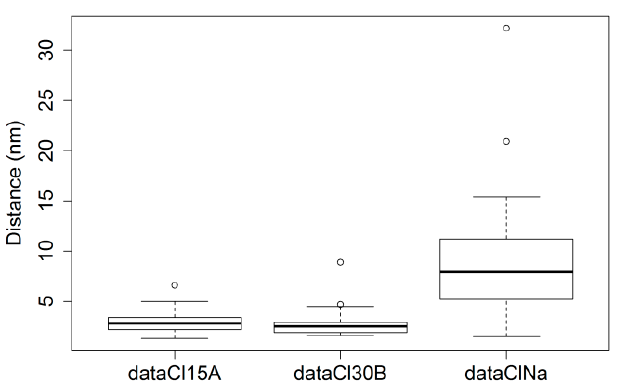
Figure 5. Boxplot representation for the measured distances between neighboring nanosheets for GelMA nanocomposite samples obtained with Cl15A, Cl30B and ClNa; outliers are represented with the circle symbol